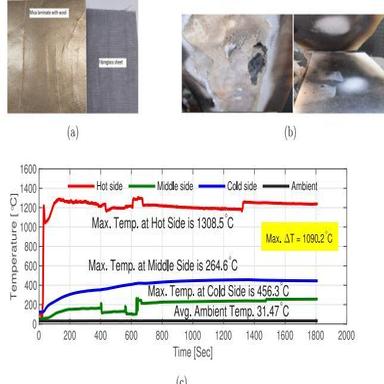
M9 — Mica laminate with wool (6 mm) + Fibre glass sheet (1 mm) (a) Before test, (b) After test, (c) Temperature plot.